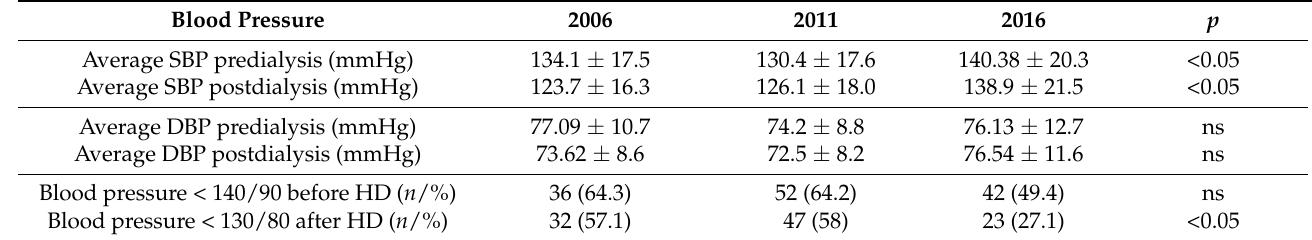
Table 2. The value of blood pressure in hemodialysis